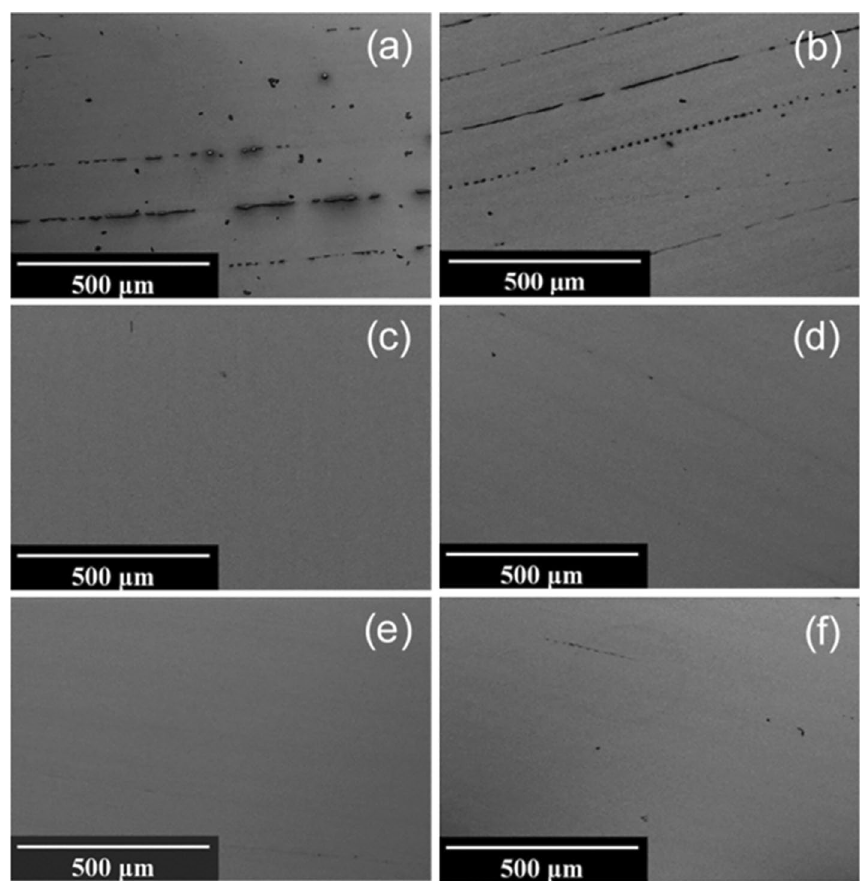
Figure 5. Scanning electron micrographs of PEN surfaces ( a ) Uncleaned, ( b ) UV-O 3 , ( c ) Piranha, ( d ) KOH + H